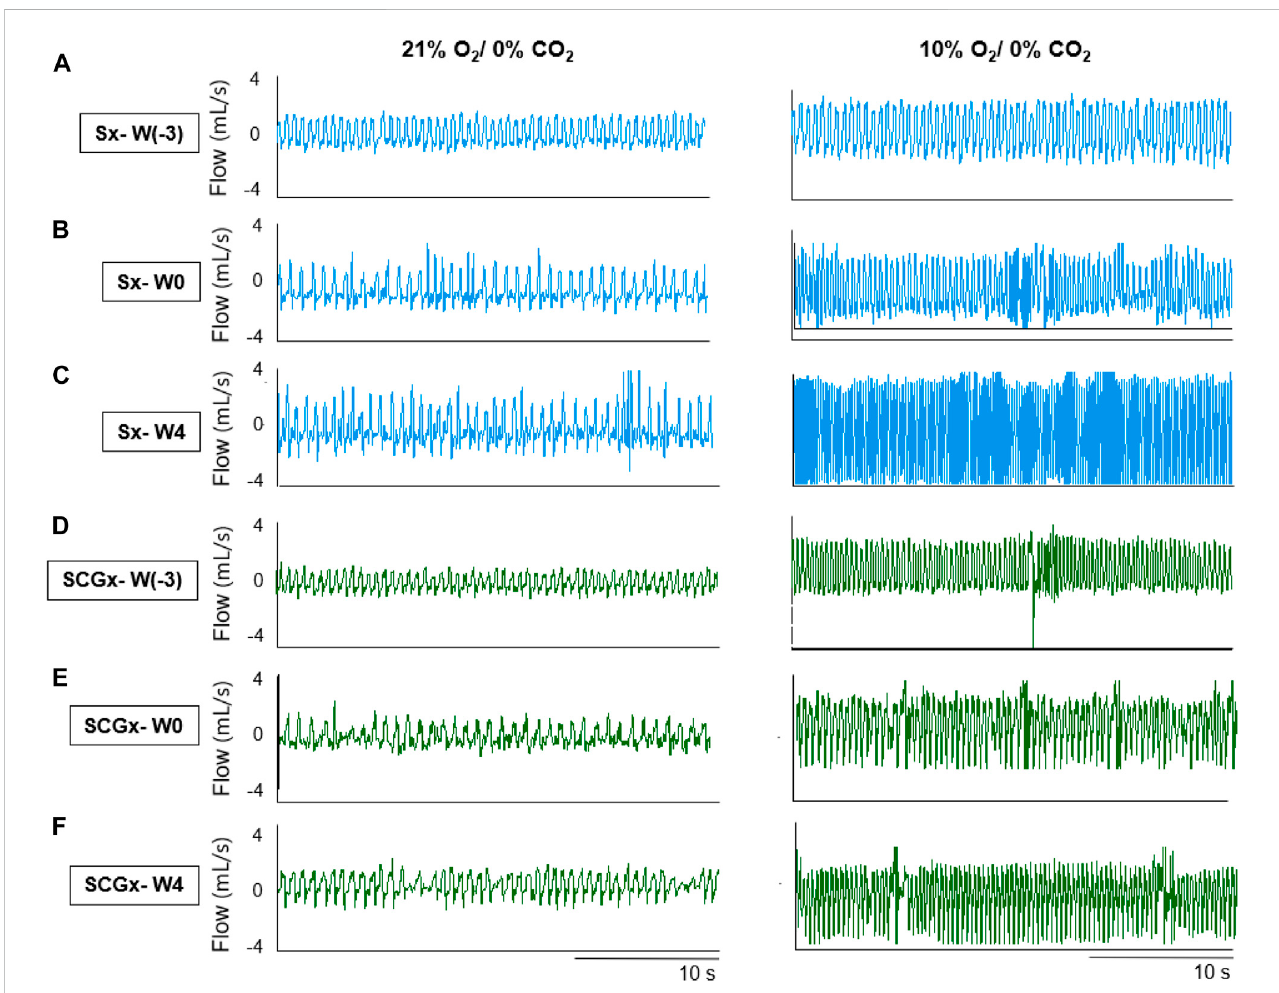
FIGURE 2 Representative recordingsofresting breathingatnormoxia(left)and 10%hypoxia (right)obtained inone ratperexperimentalgroup: (A – C) Sx (inblue)at W0, W1 and W4, respectively; (D – F) SCGx (in green) at W0, W1 and W4,